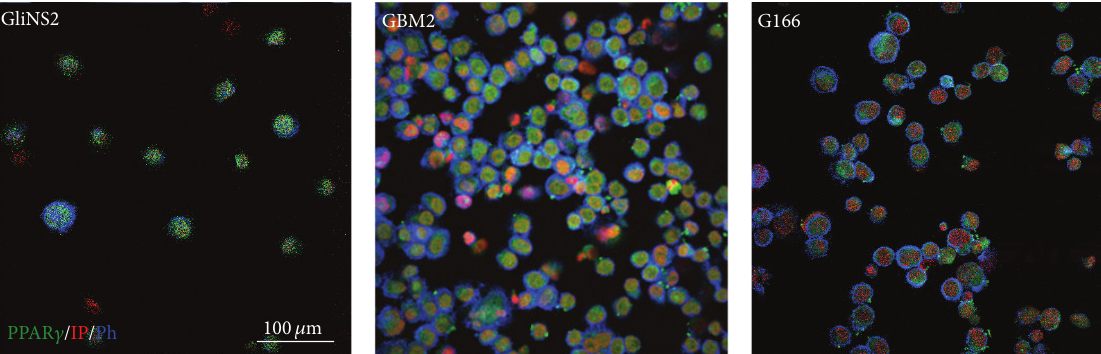
Figure 1: GSCs expressed PPAR 𝛾 . Selected images of immunofluorescence assays on GSCs. PPAR 𝛾 marker is in green; phalloidin is in blue and propidium iodide in